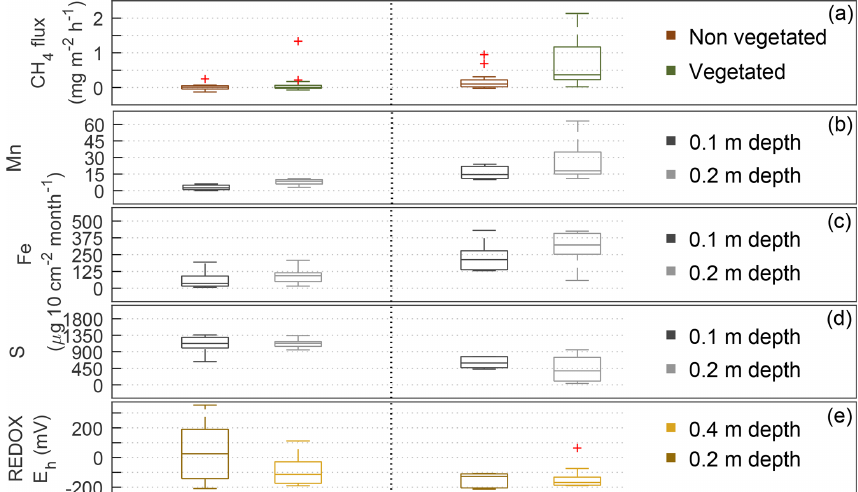
Figure 5. CH 4 fluxes (a) , net rates of ion adsorption measured with PRS ion exchange resins (b, c, d) , and the REDOX potential (e) measured every 15min at 0.2 and 0.4m over the burial period in the lowland moisture gradient plots in August 2015. Box plots represent the interquartile range, with whiskers as 95% and lines representing the median for the nine plots ( n = 4 for the saturated category where there was standing water; n = 5 for the unsaturated category, where mean 0–0.20m volumetric water content was